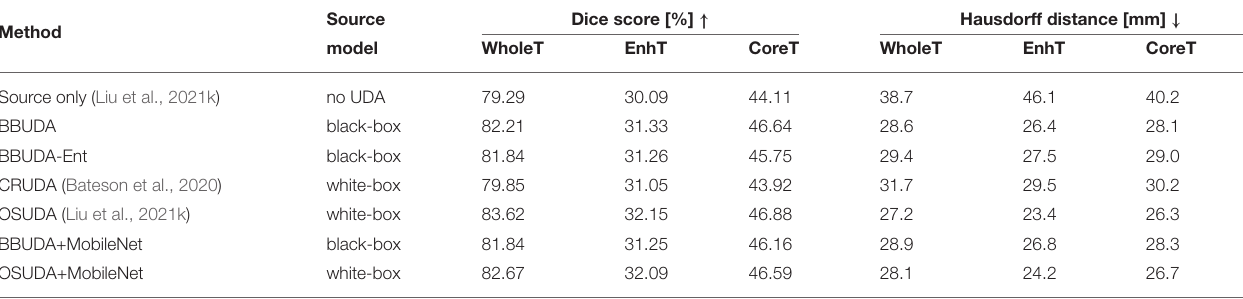
TABLE 1 | Quantitative comparisons w.r.t. DSC and HD of HGG to LGG black-box.